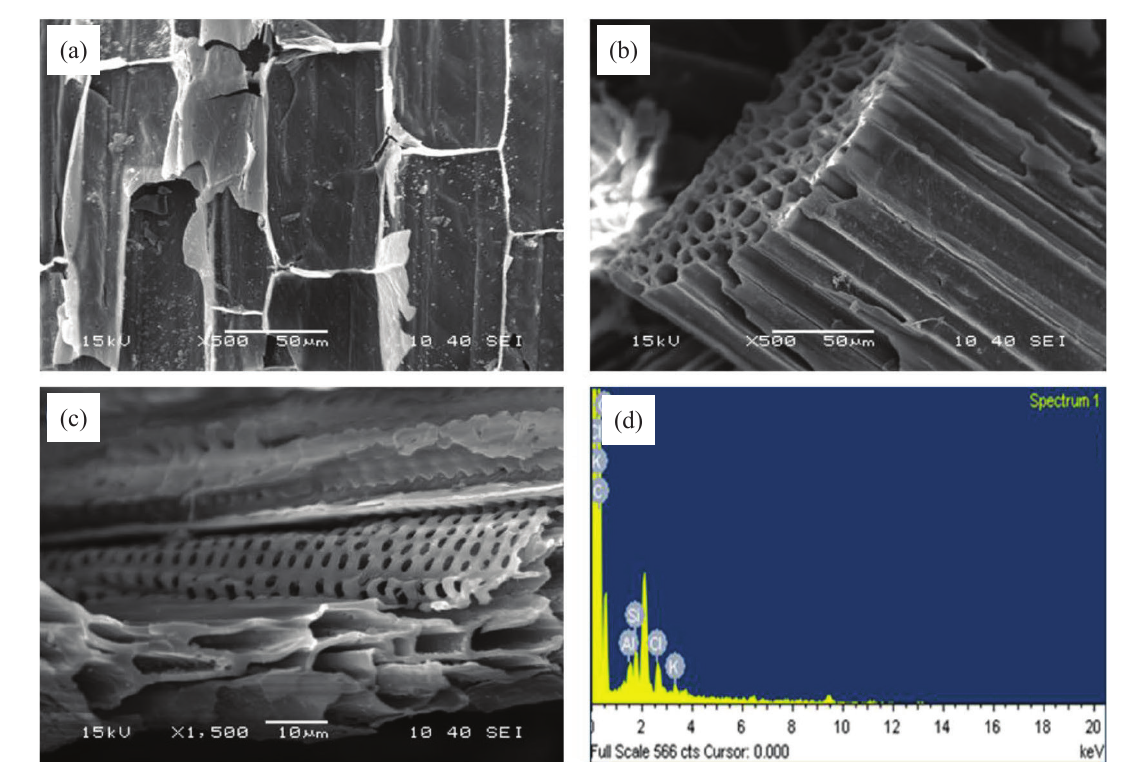
Fig. 4 – Micrographs of SEM analysis for RSAC (a) 500x magnification, (b) 500x magnification, (c) 1500x magni- fication, (d) EDX spectrum of RSAC